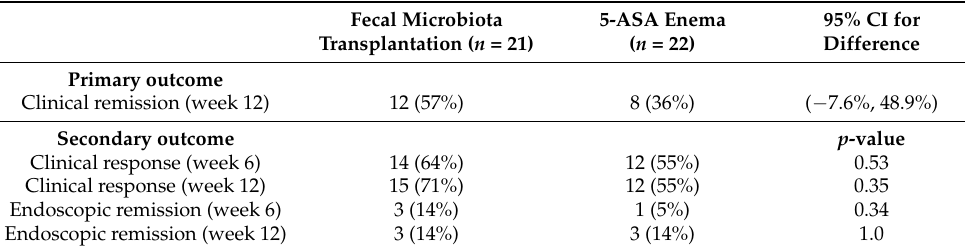
Table 2. Primary and secondary outcomes at weeks 6 and 12.